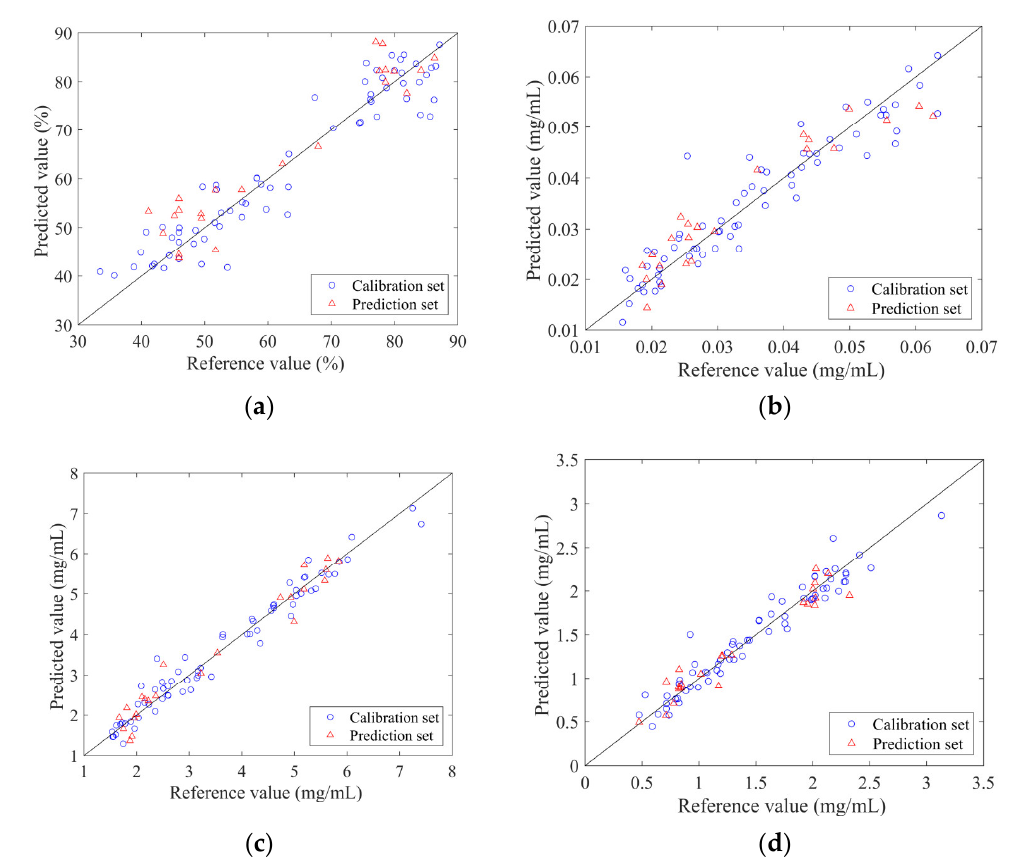
Figure 4. The scatter plot of reference measurements and NIR predictions using the optimal traditional PLSR model: ( a ) ANTI-NO; ( b ) epigoitrin; ( c ) geniposide; ( d )